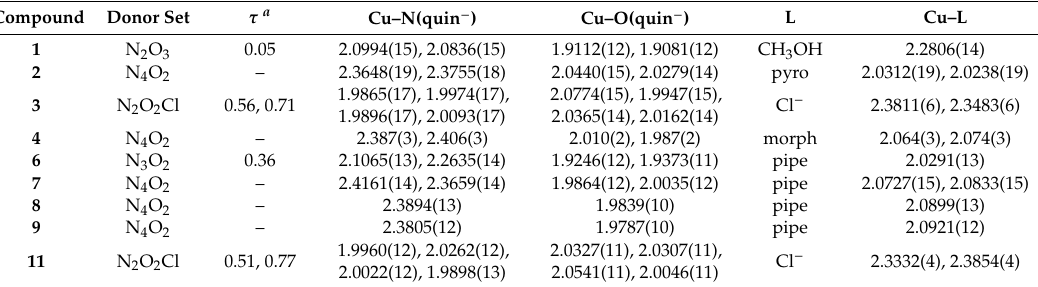
Table 1. Relevant bond lengths [Å] in 1 – 11